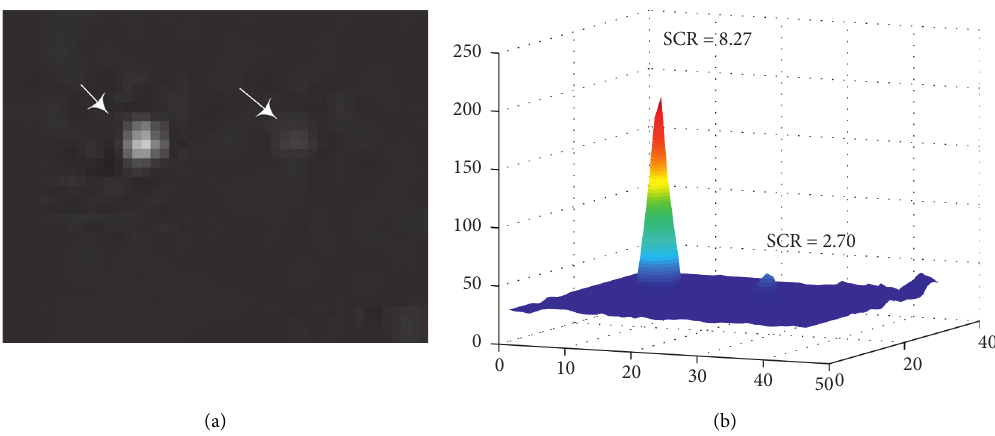
Figure 7: (a) Image with two small targets. (b) SCR of the two small targets in 3D view.